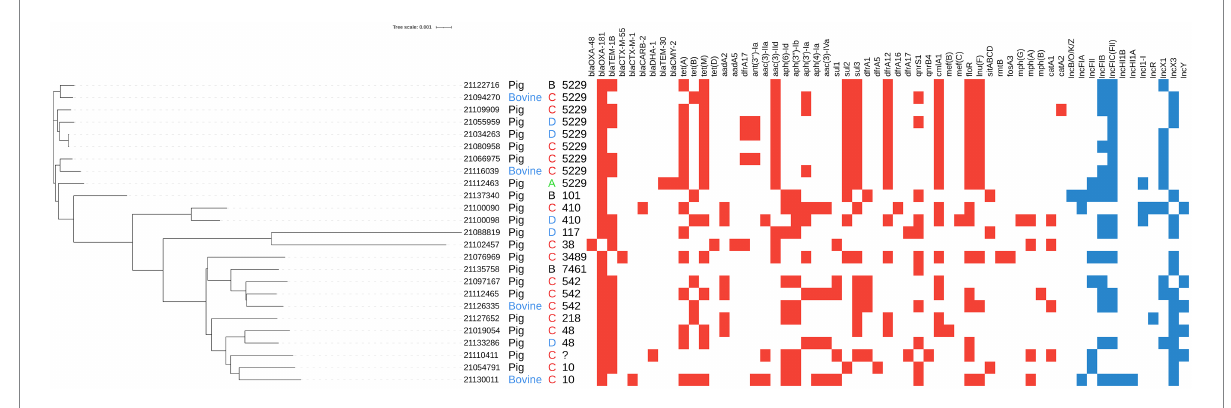
FIGURE 1 Mash clusterization of the complete genome, resistome and plasmidome of the 25 OXA-181-producing Escherichia coli isolated from caecal samples collected at slaughterhouse during the monitoring activities. From left to right: isolate ID, host (pig in black letters, bovine in blue letters), region anonymized and ST. Colored squares indicate the presence of resistance genes (red squares) and plasmid replicons (blue